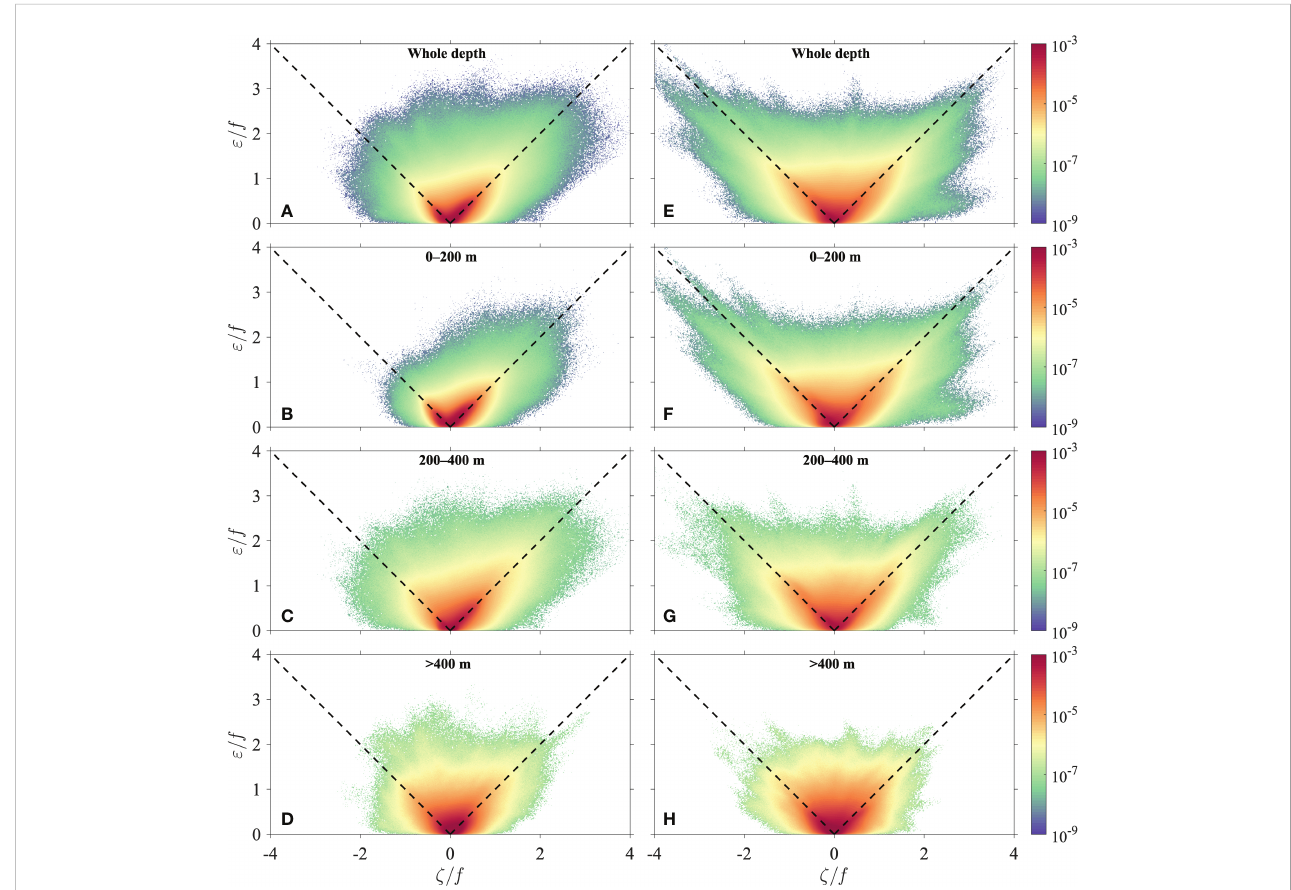
FIGURE 3 Statistics for the joint probability density distribution of strain rate vs. relative vorticity of different layers from 2003 to 2012. The domain was classi fi ed using a bin size of 0.01, and the values were normalized by the sum of each layer. Two diagonal dashed lines corresponded to e =± z . The left (A – D) and right (E, F) panels correspond to the continental slope area for the Kuroshio before turning directly to the strait and lee area of the Tokara Strait for the Kuroshio after fl owing through the Tokara Islands,